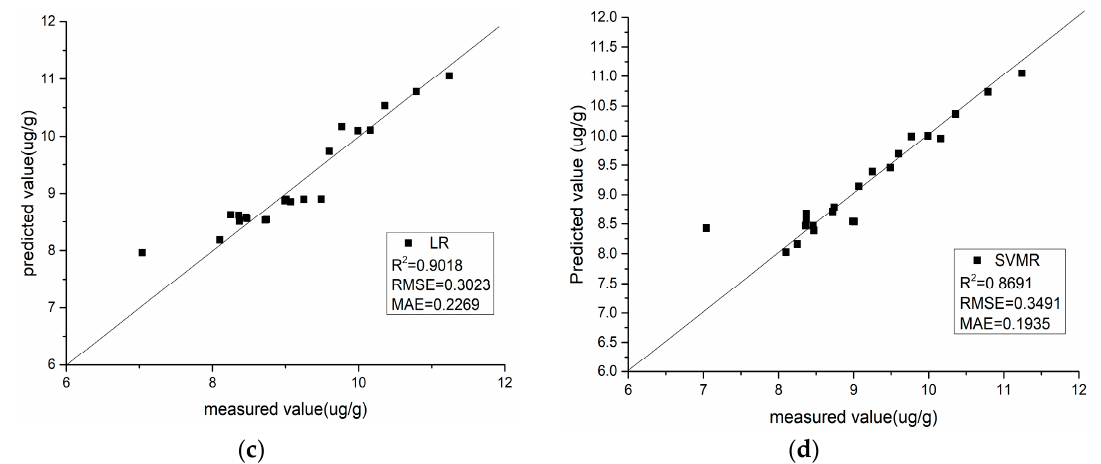
Figure 9. A comparison between the measured values and predicted values of the different regression models for Daye. ( a ) Gradient boosting regression tree model. ( b ) Random forest regression model. ( c ) Linear regression model. ( d ) Support vector machine regression model.